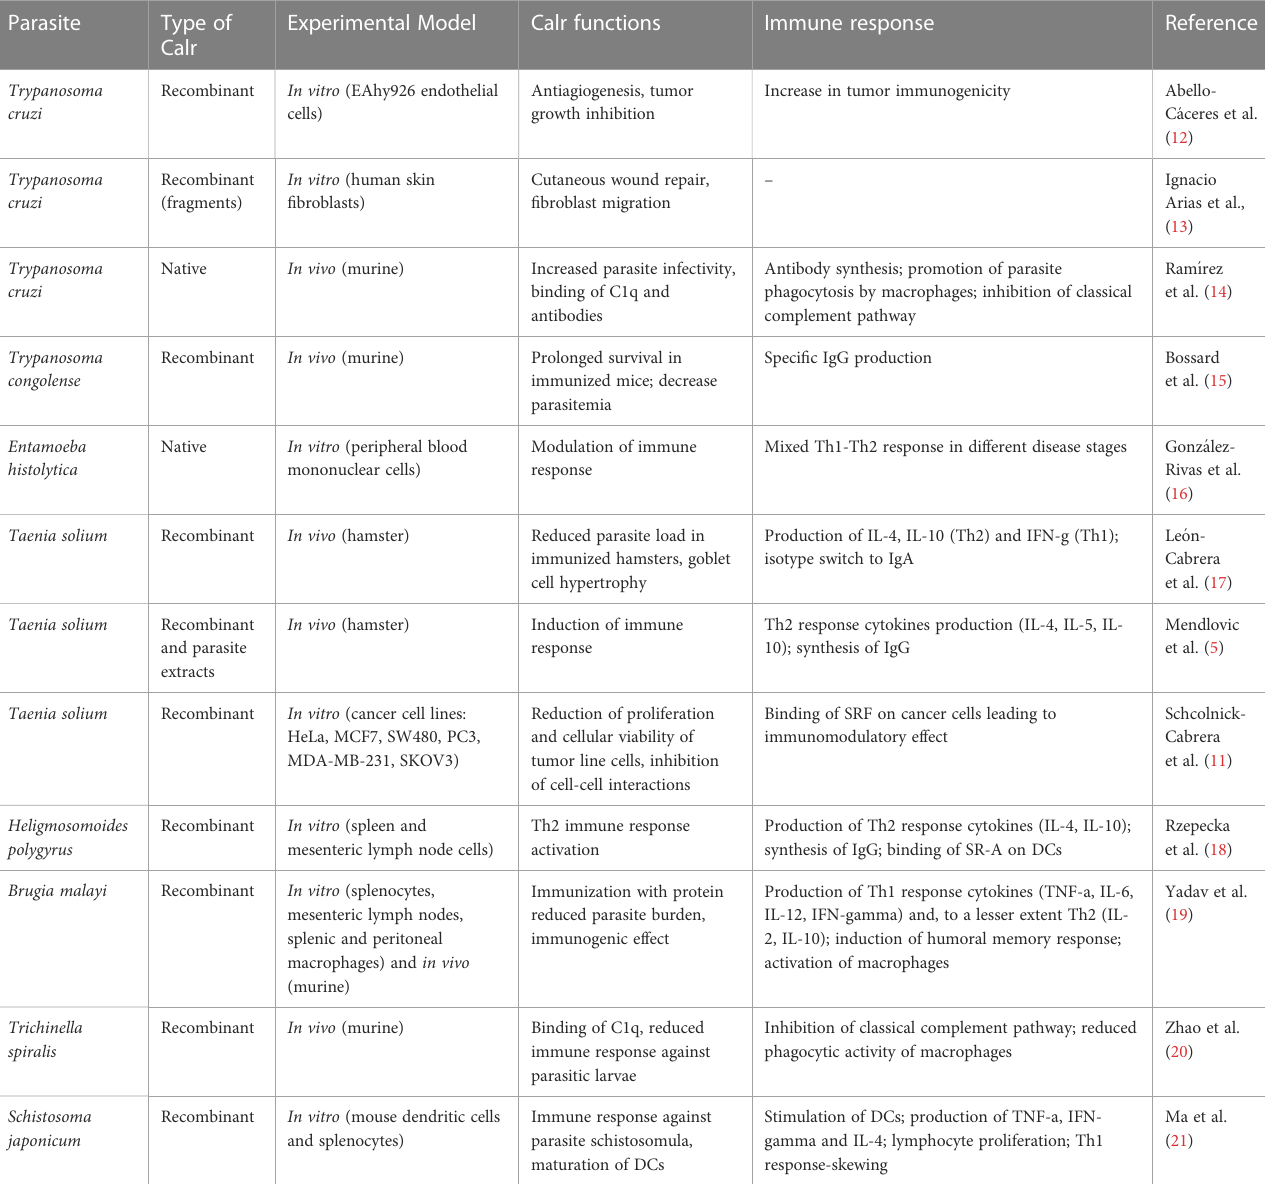
TABLE 1 Functions and immune response elicited by parasite